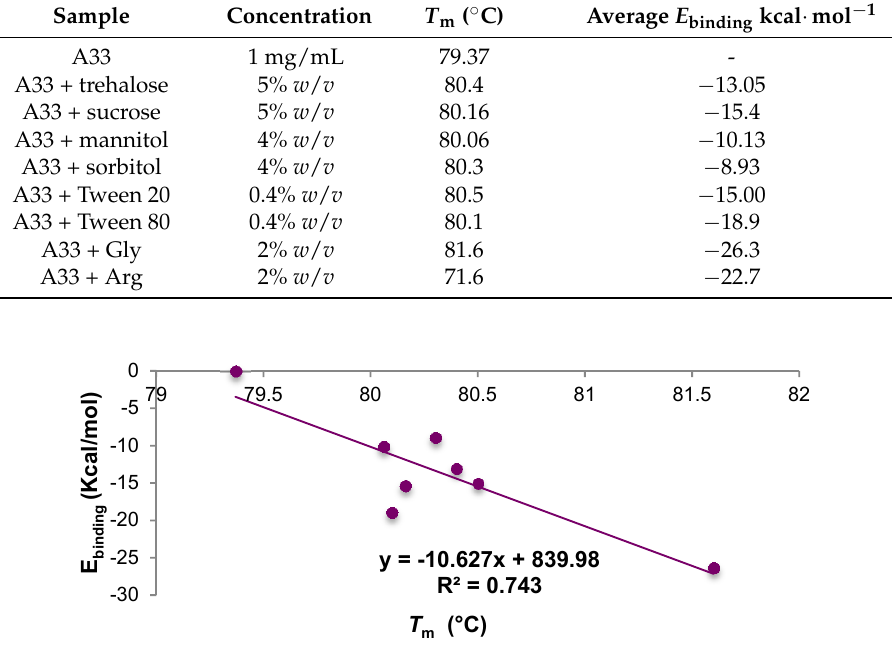
Figure 12. Correlation between molecular docking results, expressed as a binding affinity and experimental results, T m .